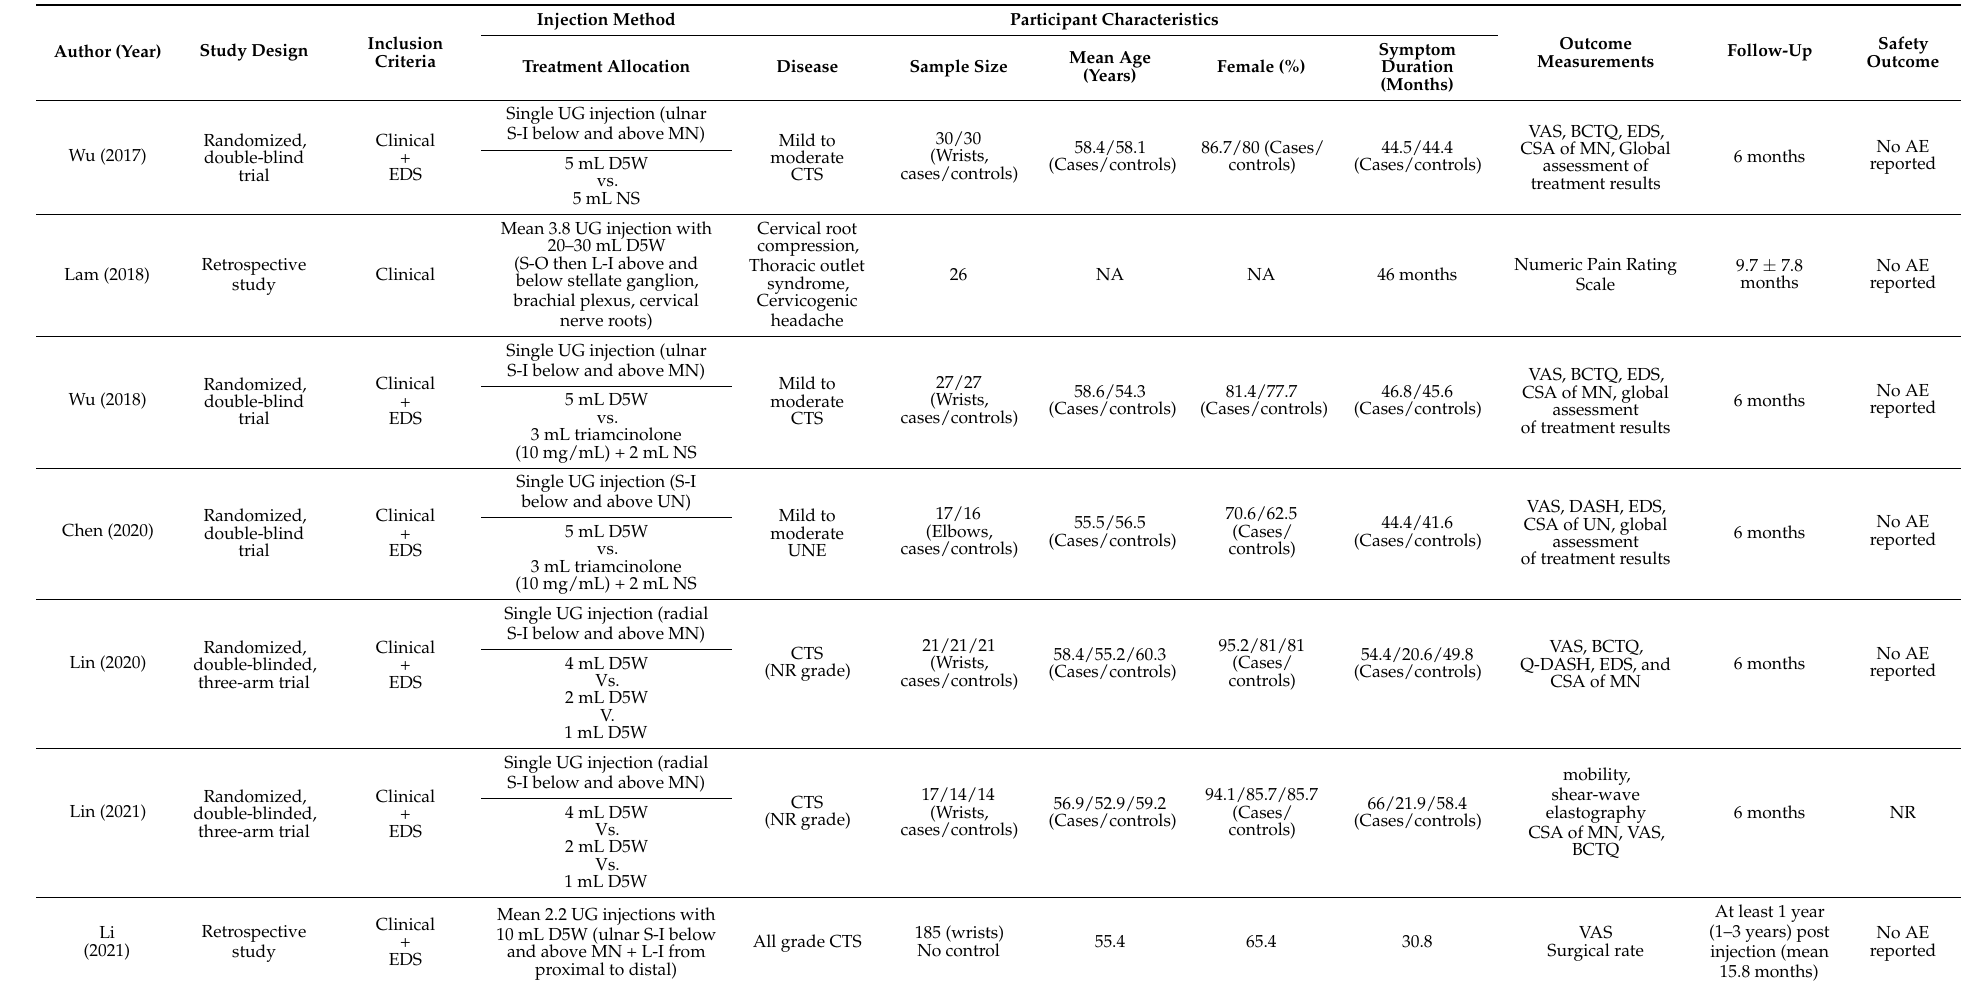
Table 1. Summary of included clinical